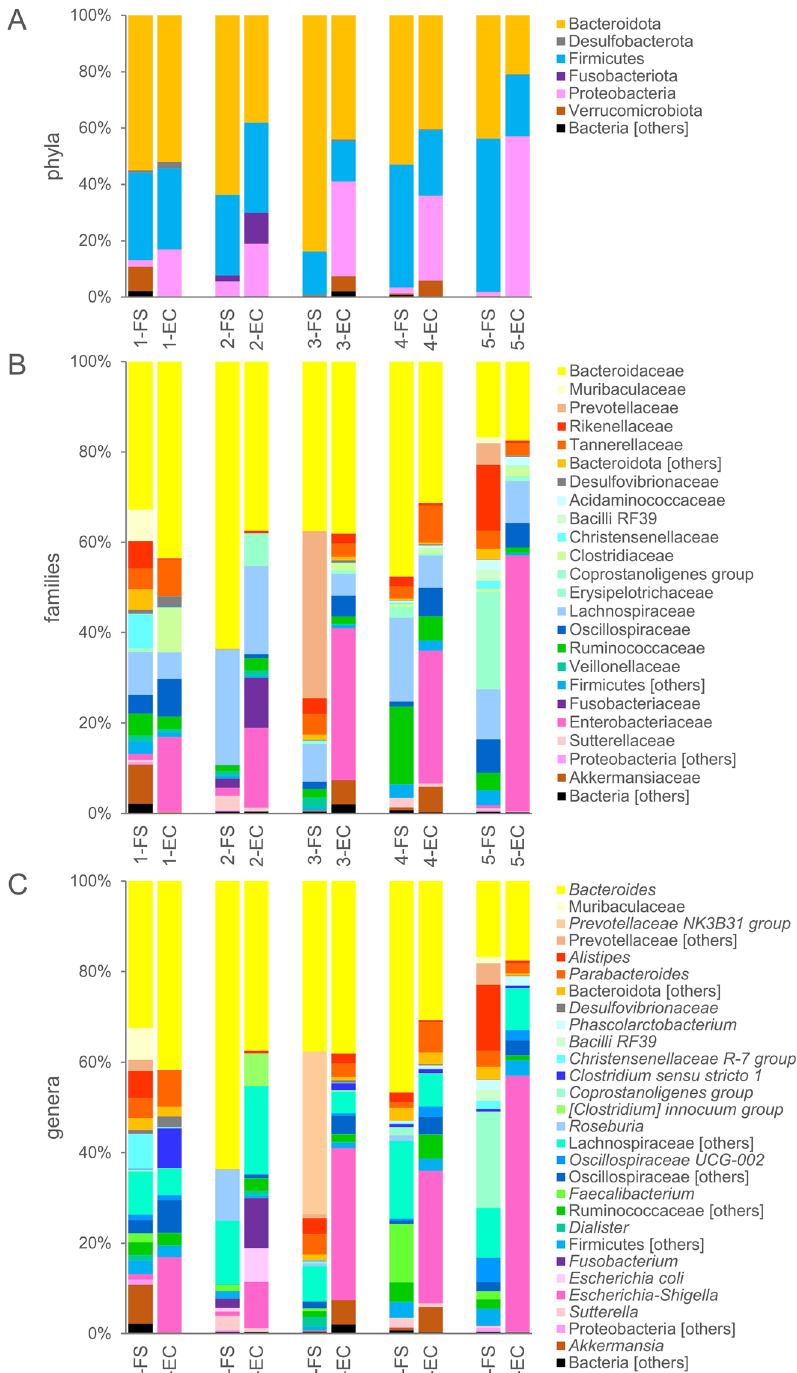
Figure 2. Stacked bar-plot representation of microbiota composition before and after the enrichment in MM, with taxonomic features collapsed at the level of phyla ( A ), families ( B ), and genera ( C ). The taxa that remained unclassified at the deeper level or that never occurred with abundance higher than 0.5% are grouped and marked with